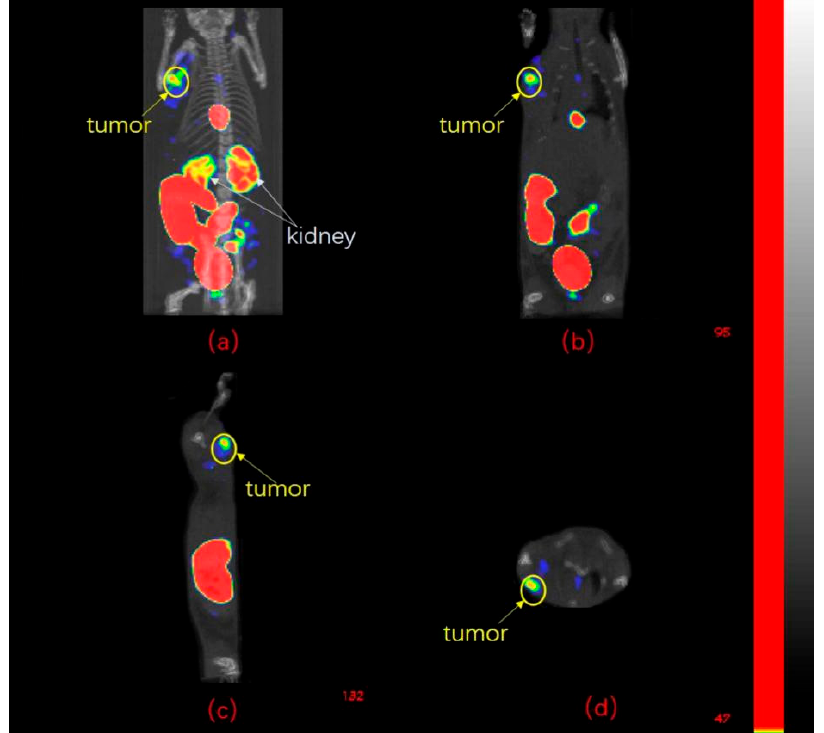
Figure 4. Single-photon emission computed tomography (SPECT)/CT images of [ 99m Tc]Tc-tricine- TPPTS-HYNICNM in Kunming female mice bearing S180 tumors at 2 h post-injection: ( a ) visual imaging; ( b ) coronal section; ( c ) sagittal section; ( d ) transverse